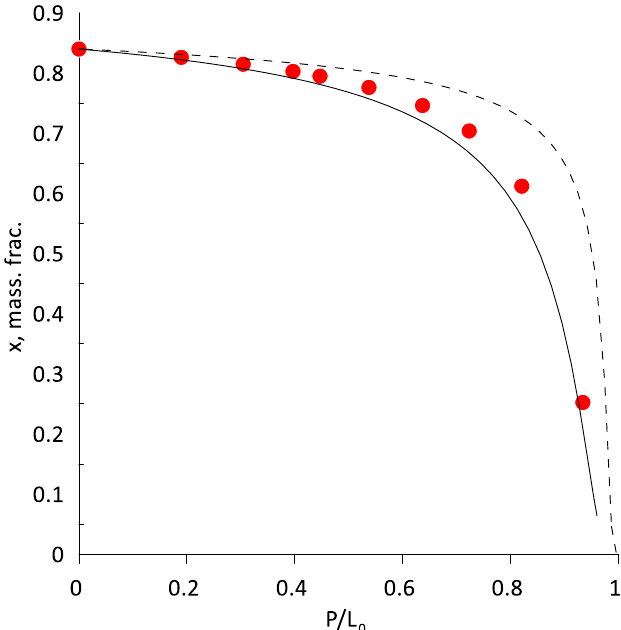
Figure 5. Residual curves for the ethanol–water–AEPA-Gl mixture at [AEPA-Gl] = 20 wt.% (geometric figures are experimental data, continuous line is calculated data). Dotted lines are calculated values for the ethanol–water mixture.